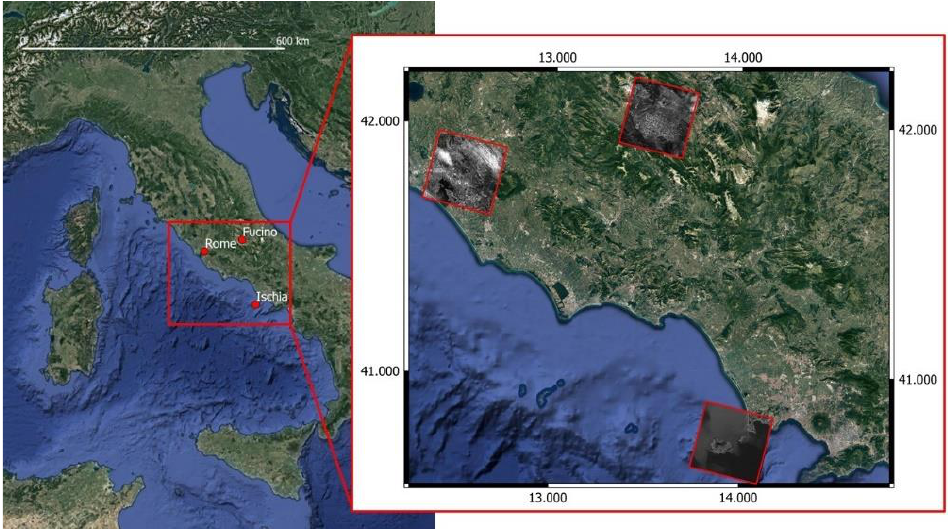
Figure 1. Location of the three test fields. Table 1. Main features of PRISMA images.